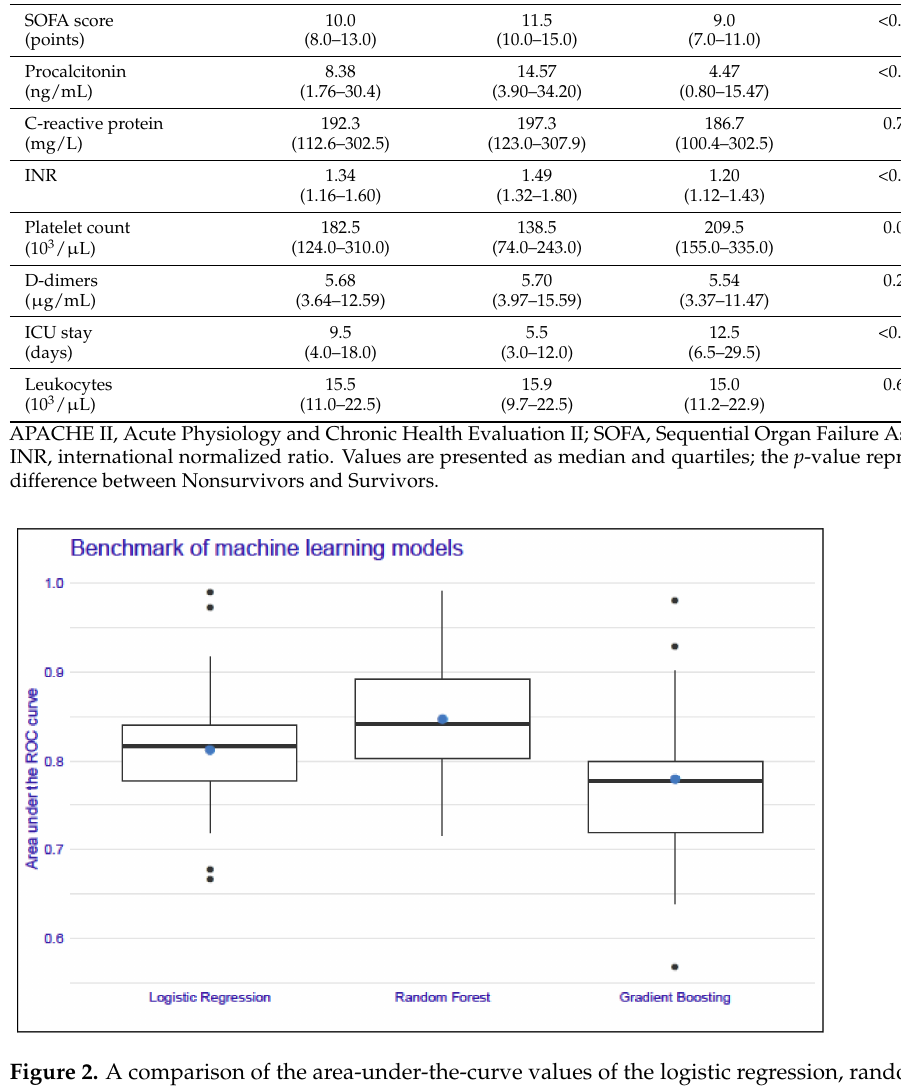
Figure 2. A comparison of the area-under-the-curve values of the logistic regression, random forest, and gradient boosting models. The mean test AUC was the highest for the random forest model, whereas the lowest mean test AUC was for the boosting model. The blue dot represents the mean and the bold midline represents the median of the AUC results, whereas the upper and lower limits of the boxes correspond to the third and first quartiles. Black dots represent outliers in the data. Each boxplot presents the results of a 5-fold cross-validation procedure repeated five times for a specific